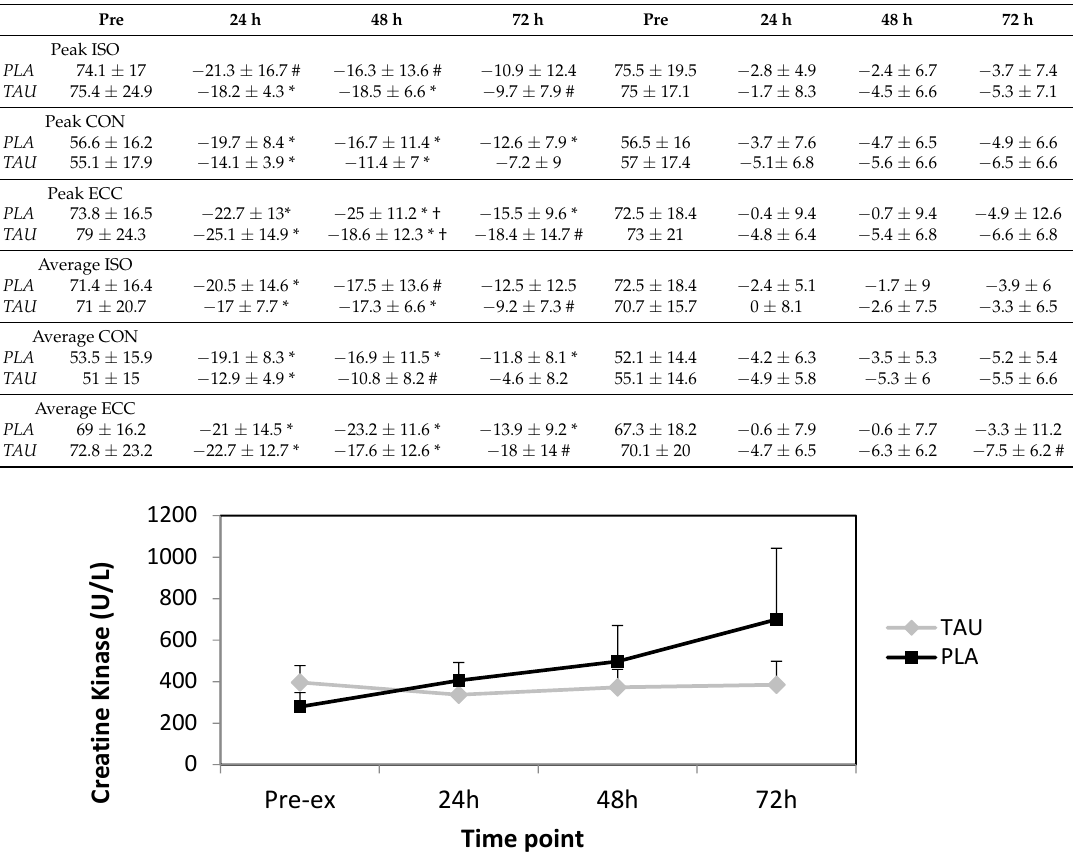
Table 1. Changes in torque (Nm) following strenuous eccentric exercise (mean ± SD). ISO = isometric, CON = concentric, ECC = Eccentric, PLA = placebo, TAU = taurine. * Significantly different to pre-exercise value ( p < 0.01), # significantly different to pre-exercise value ( p < 0.05). † Significantly different between trials ( p < 0.05).